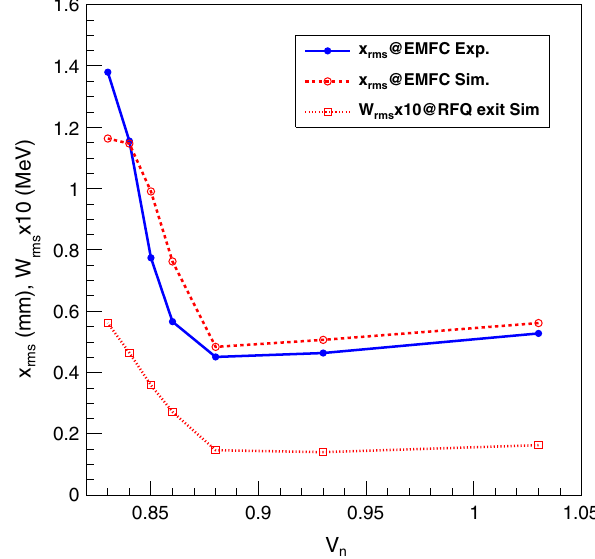
FIG. 11. Measured and simulated beam widths at the EMFCx as functions of V n . The simulated energy spreads at the RFQ exit are also